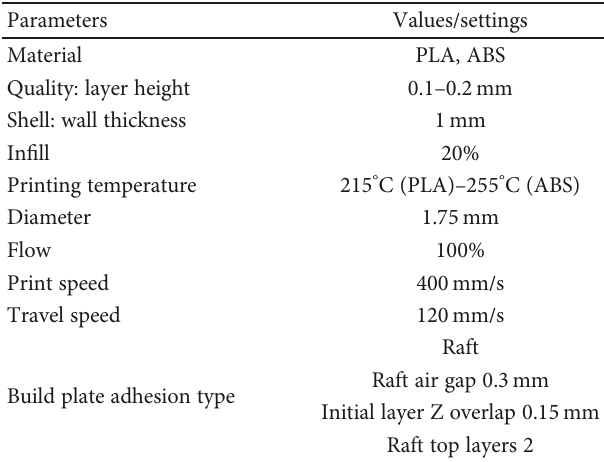
Figure 6: 3D printed models of a 33-week-old fetus with the two di ff erent systems: (a) Zortax and (b) Prusa i3. Table 1: Printing